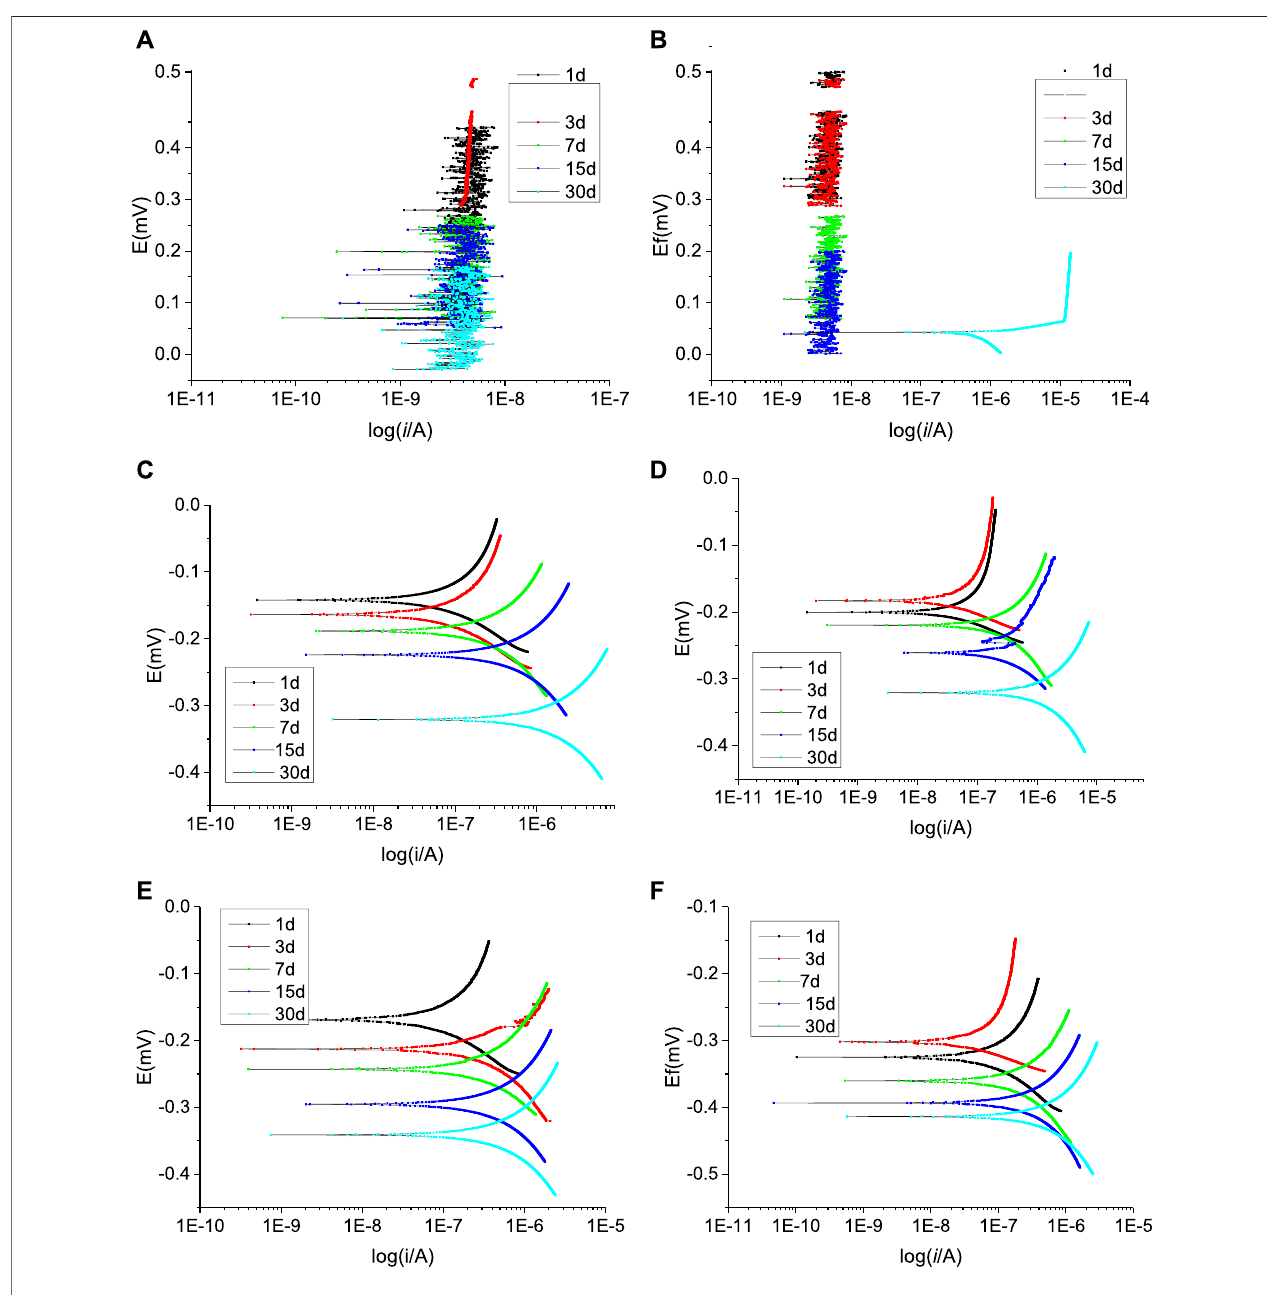
FIGURE 6 | Polarization curves of different specimens (A) S1, (B) S4, (C) S2, (D) S5, (E) S3, and (F) S6.